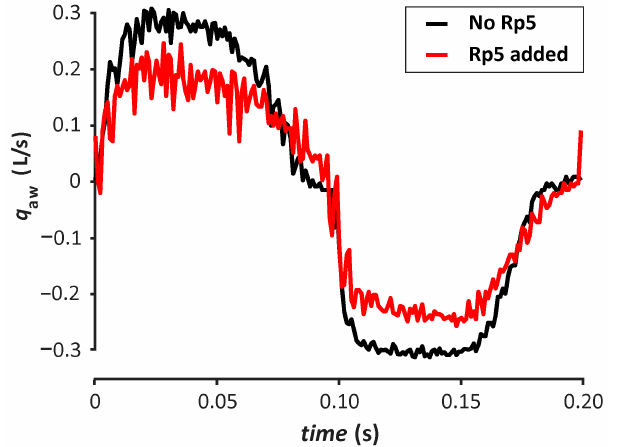
Figure 3. Comparison of the measured flow signal prior to and after the addition of the Rp5 resis-